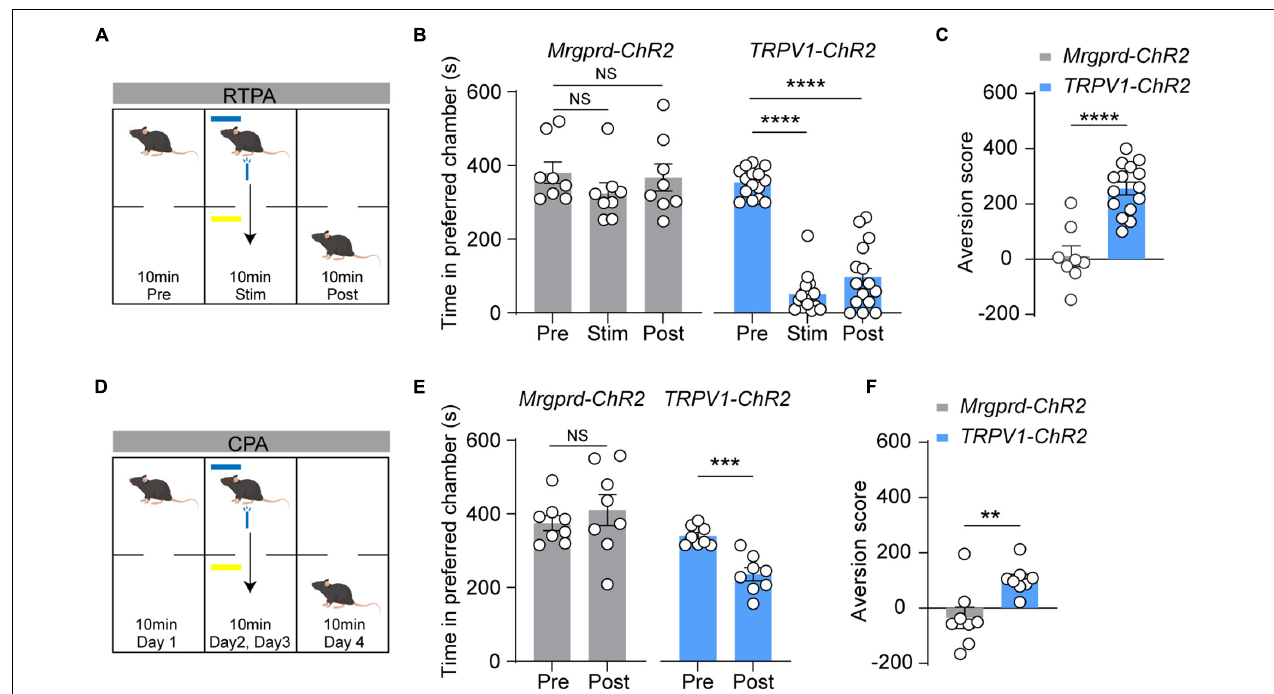
FIGURE 3 | Blue light-induced RTPA and CPA in naïve TRPV1-ChR2 mice but not naïve Mrgprd-ChR2 mice. (A) Schematic drawing of RTPA experiment (see Methods). (B,C) Time spent in preferred chamber and aversion score of RTPA. Blue light stimulation induces strong aversion in naïve TRPV1-ChR2 but not Mrgprd-ChR2 mice for RTPA ( Mrgprd-ChR2 , n = 8 animals, TRPV1-ChR2, n = 15 animals). (D) Schematic drawing of CPA experiment (see Methods). (E,F) Time spent in preferred chamber and aversion score of CPA. Blue light stimulation induces strong aversion in naïve TRPV1-ChR2 but not Mrgprd-ChR2 mice for CPA. ( Mrgprd-ChR2 , n = 8 animals, TRPV1-ChR2, n = 8 animals). Data are presented as mean ± SEM. “NS,” no significance, ** p < 0.01, *** p < 0.001, **** p < 0.0001. One-way repeated-measures ANOVA with holm-sidak test for (B) ; paired Student’s two-tailed t -test for (C,E) ; unpaired Student’s two-tailed t -test for (F)